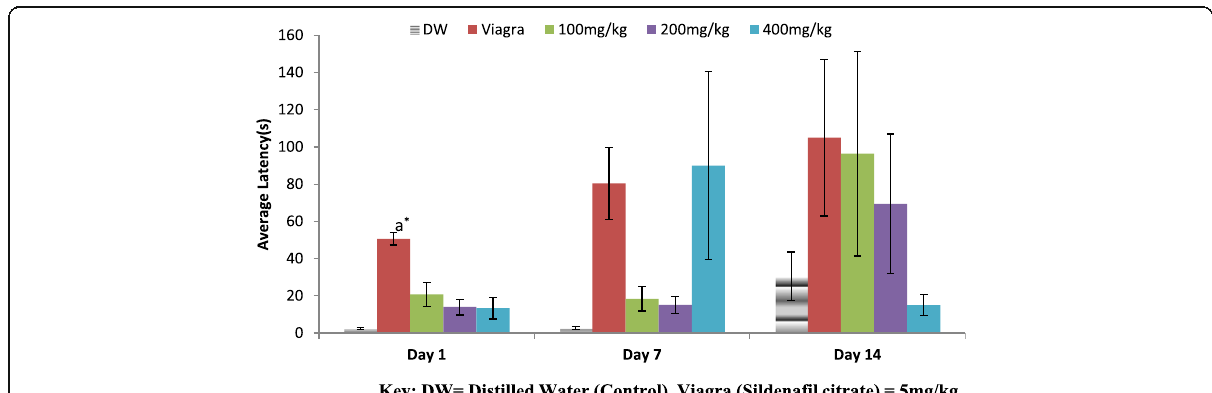
Fig. 5 Effect of ethanol extract of A. barbadensis root on ejaculatory latency of male rats. Bars with different letters are significantly different; bars with letters are significantly different from bars without letters while those with no letters are not significantly different from each other on each day. Bars with different numbers for the same dose group at different days are significantly different while those without numbers are not significantly different. All values are expressed as Mean ± SEM; n = 5;** P < 0.01; * P <